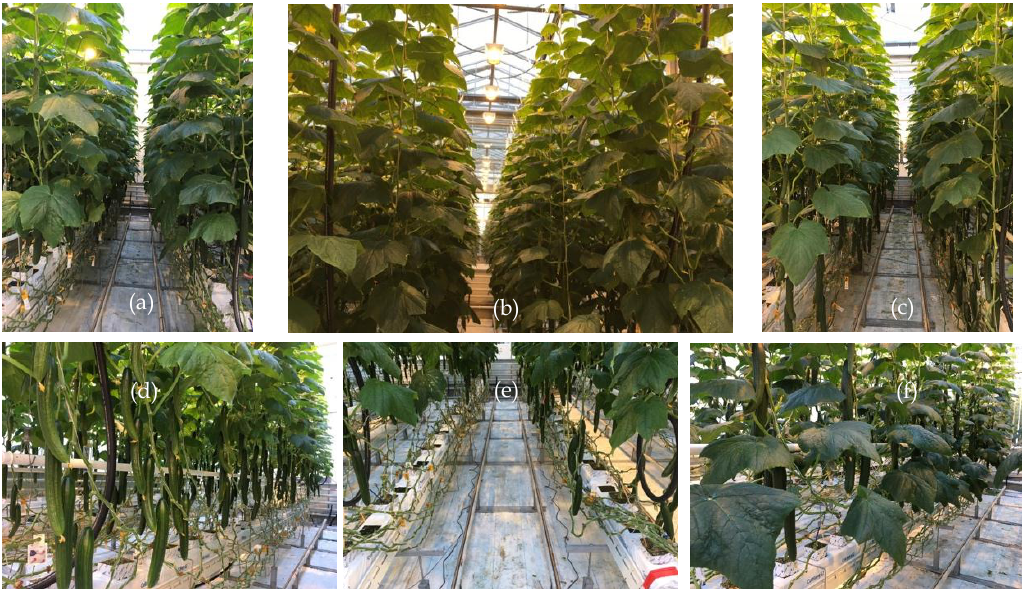
Figure A3. Cucumber crop after 4 months, pictures of different compartments of teams: ( a ) iGrow; ( b ) deep_greens; ( c ) AiCU; ( d ) Sonoma; ( e ) Reference; ( f ) The Croperators.